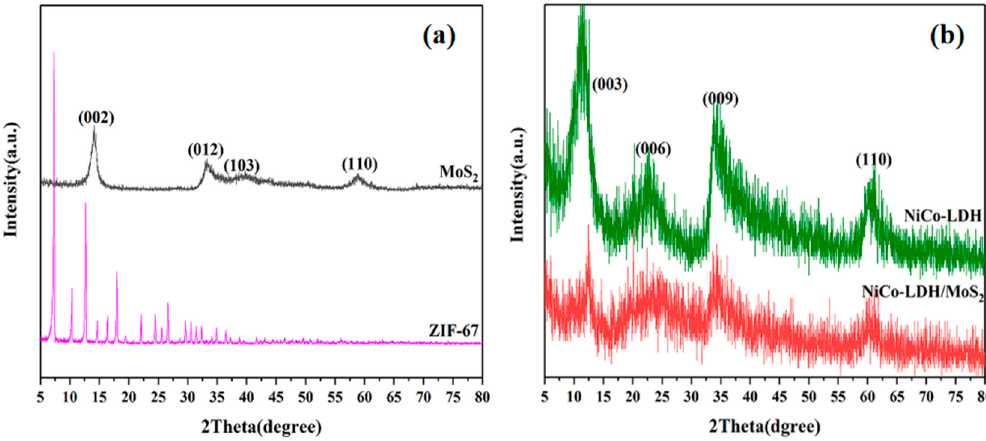
Figure 2. XRD patterns of MoS 2 , ZIF-67 ( a ) and NiCo-LDH, NiCo-LDH/MoS 2 ( b ).